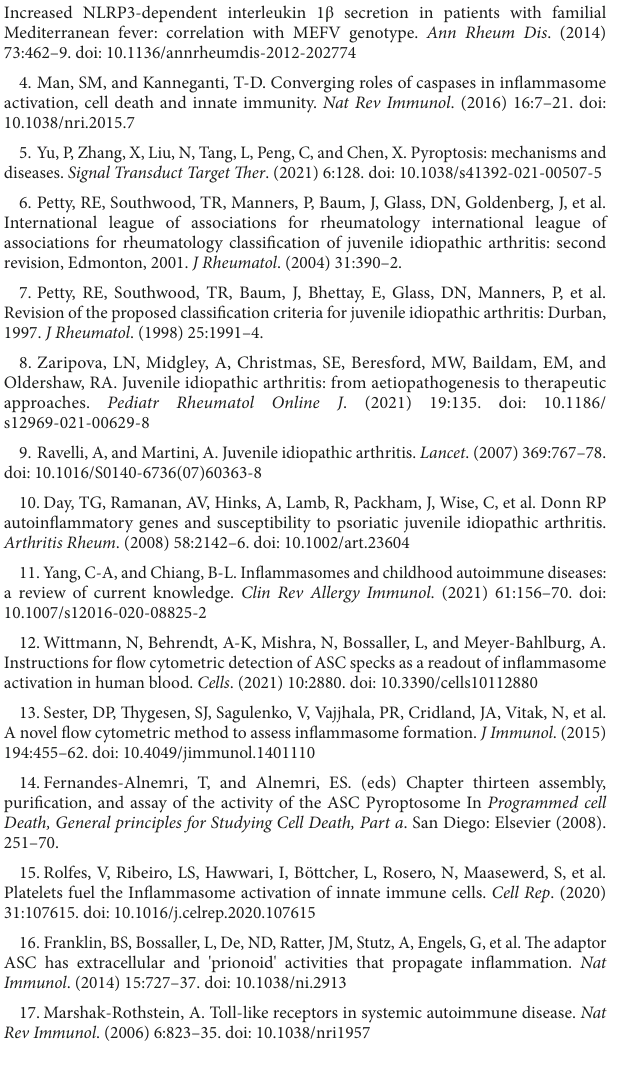
SUPPLEMENTARY FIGURE S1 Increased amount of ASC speck + monocytes in patients with higher ANA titer. Quantification of data from JIA patients. Mann–Whitney-U-test was performed, shown mean ± SEM. A p-value * p < 0.05 was considered significant.